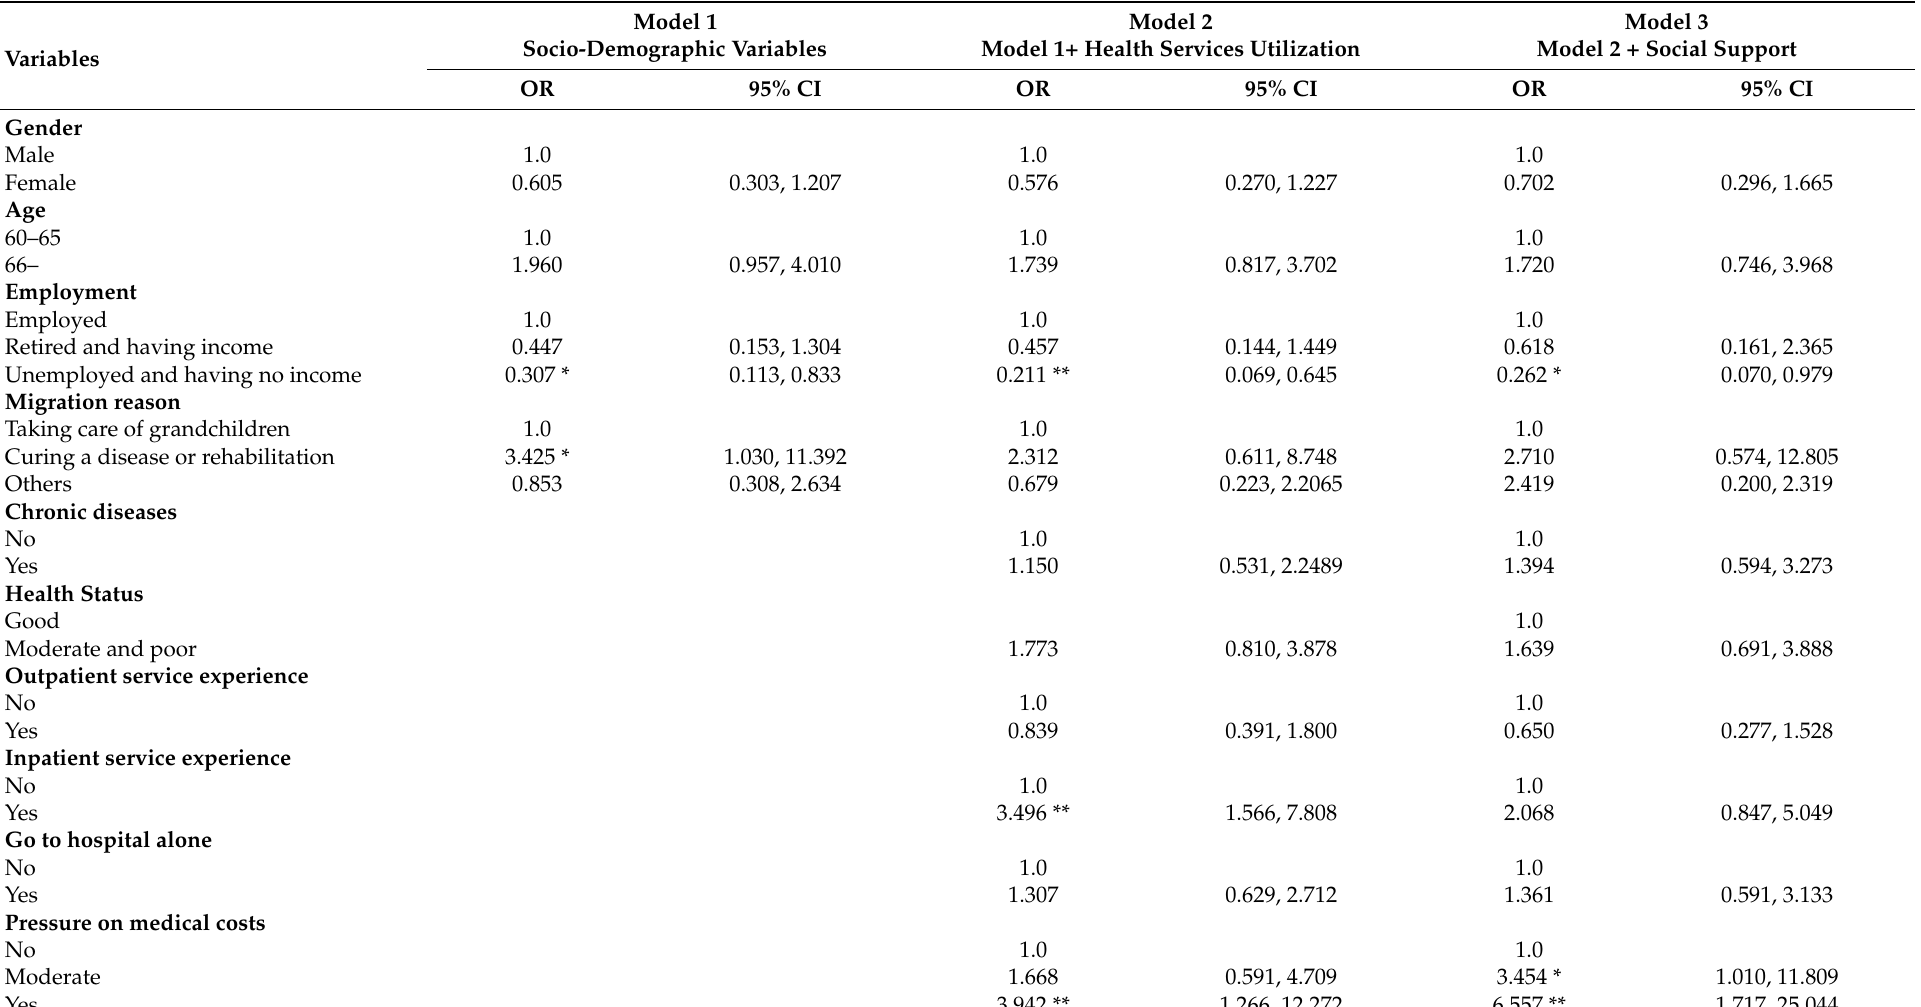
Table 2. Binary logistic regression for relationships between related variables and depression of